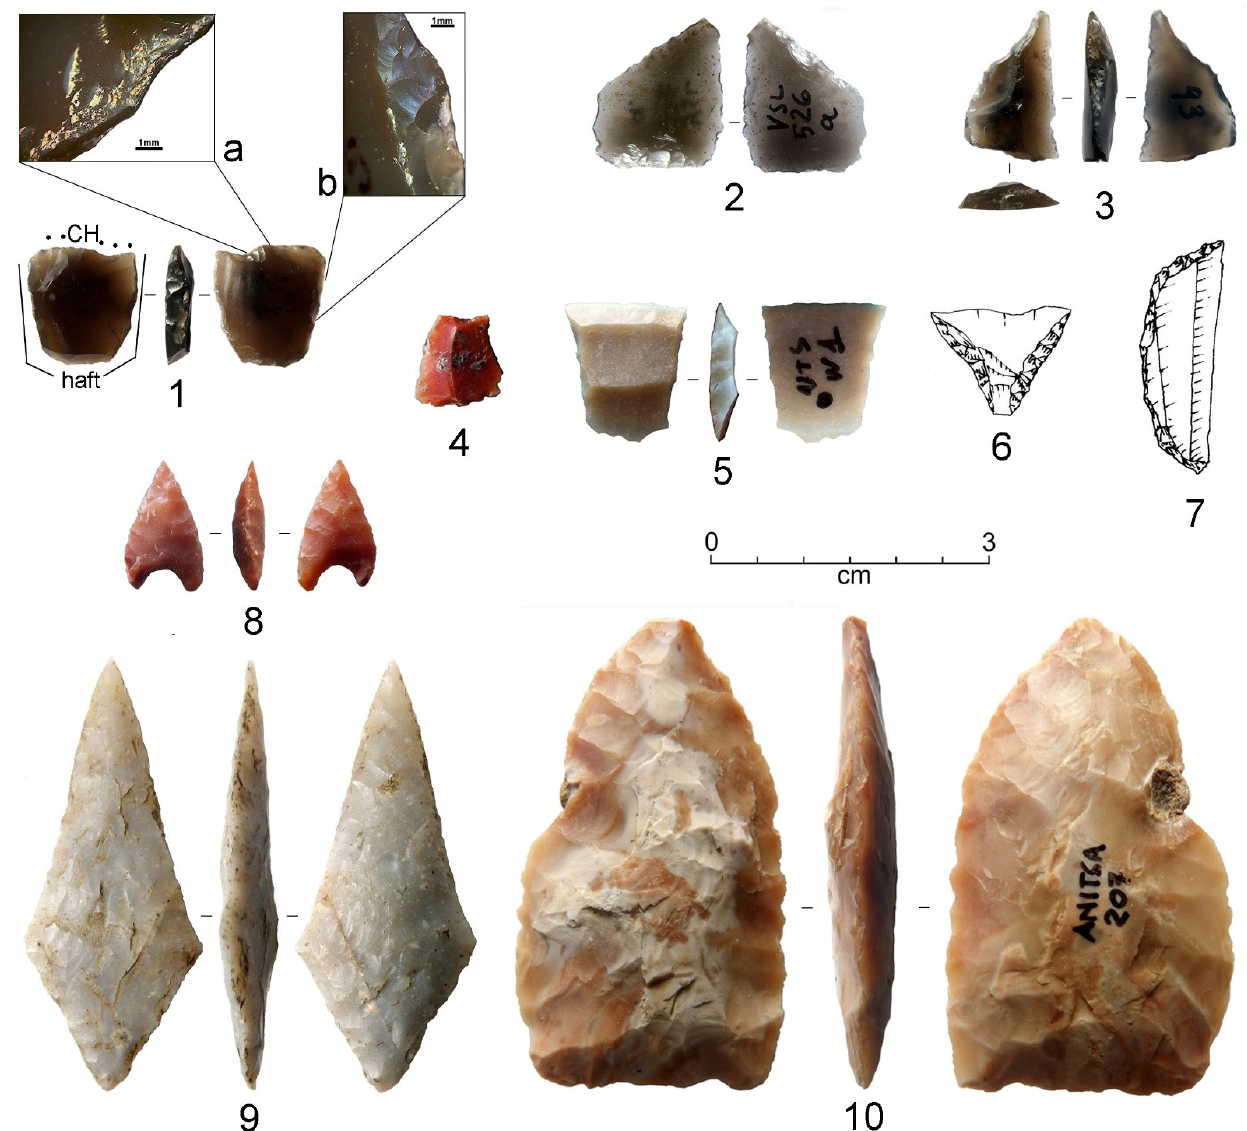
Figure 18. Different types of non-local chert geometric microliths from different sites: VSL-145 (n. 1: Vikos “black chert”: wear traces: cut hard (CH), ( a ); hafting, ( b ), VSL-526a (n. 2: Vikos “black chert”), VLC-93 (n. 3: Vikos “black chert”), Sam-23 (n. 4), NTSW-4 (n. 5), Sam-11 (n. 6), and KRK-88 (n. 7); non-local chert arrowheads from Mount Anitsa northern upper slope (Anitsa-26: n. 8; Anitsa-111, n. 9; Anitsa-207, n. 10) (photographs by E. Starnini; drawings by P. Biagi; inking by G. Almerigogna).